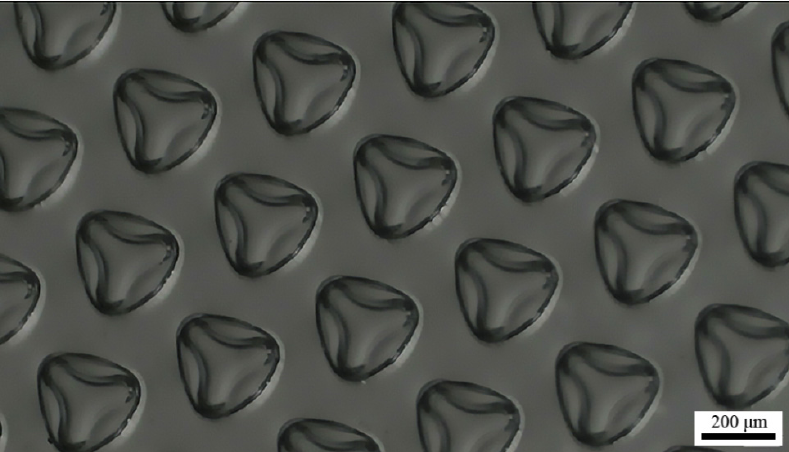
Figure 6. Optical microscope image of the microstructures fabricated through applying 60% pre-strain.